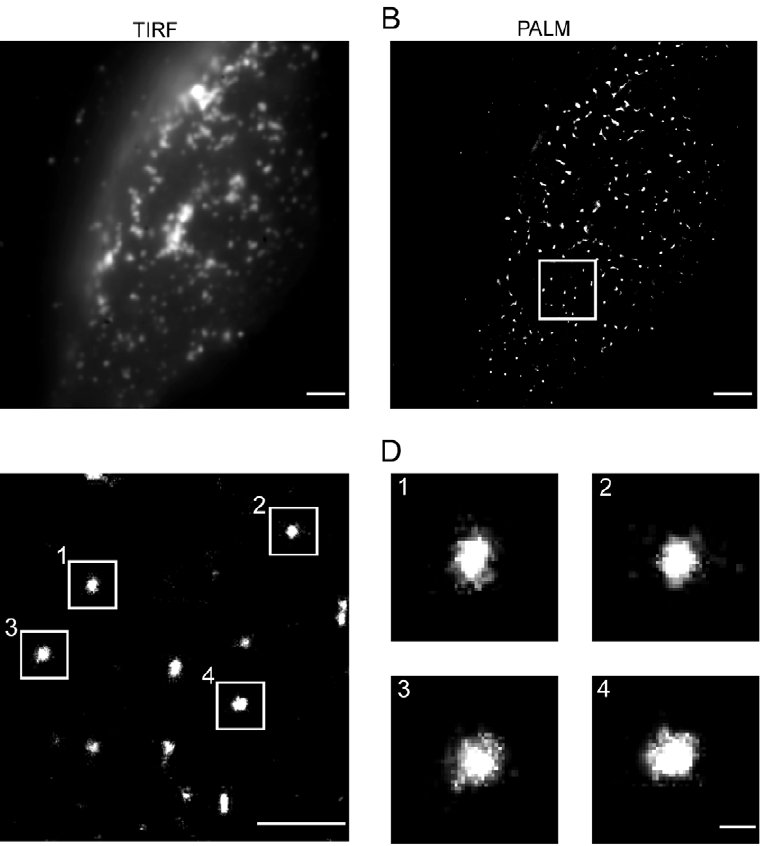
Figure 1. Distribution of Gag.mEosFP at the plasma membrane of HeLa cells imaged by super-resolution TIRF microscopy. HeLa cells were transfected with equimolar amounts of pCHIV and pCHIV mEosFP . At 24 hpt, cells were fixed and HIV-1 assembly sites were imaged by PALM as described in Materials and Methods. Summed intensity TIRF ( A ) and high resolution PALM ( B ) microscopy images of a representative cell are displayed. Scale bars correspond to 2 m m. The boxed region in (B) corresponds to the region of interest shown as an enlarged high resolution image in ( C ). Scale bar in (C) corresponds to 1 m m. ( D ) Four individual HIV-1 assembly sites from the boxed regions shown in (C). Scale bar corresponds to 100